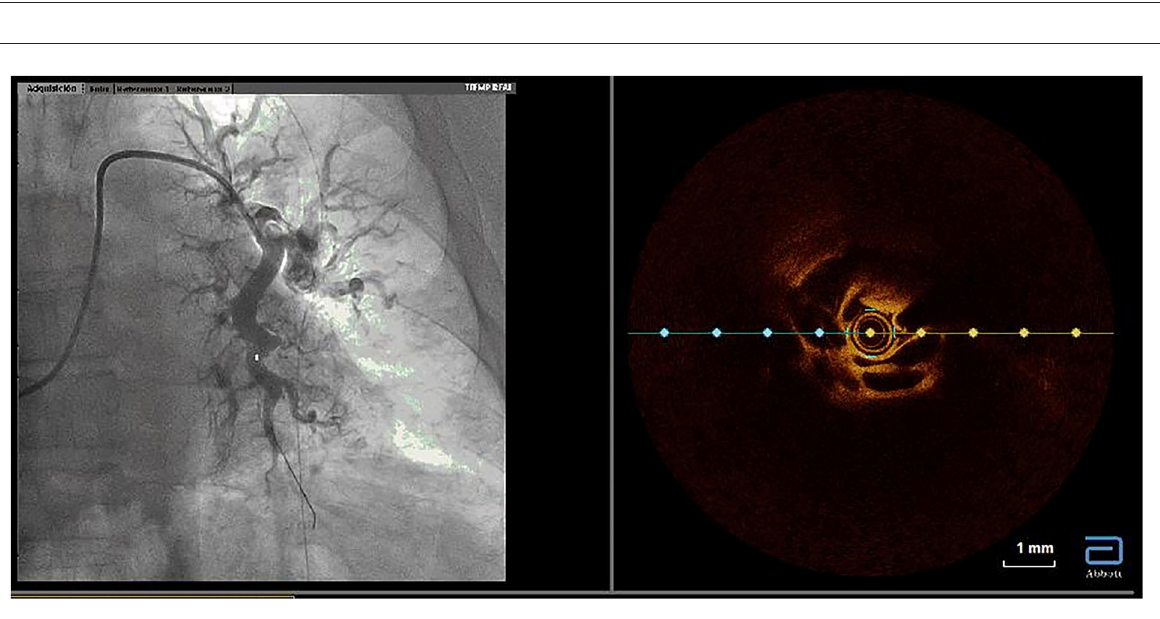
FIGURE3 Utility of optical coherence tomography to confirm CTEPH organized thrombi inside pulmonary arteries. Organized thrombi inside the superior segmental branch of the left lower lobe. CTEPH, chronic thromboembolic pulmonary